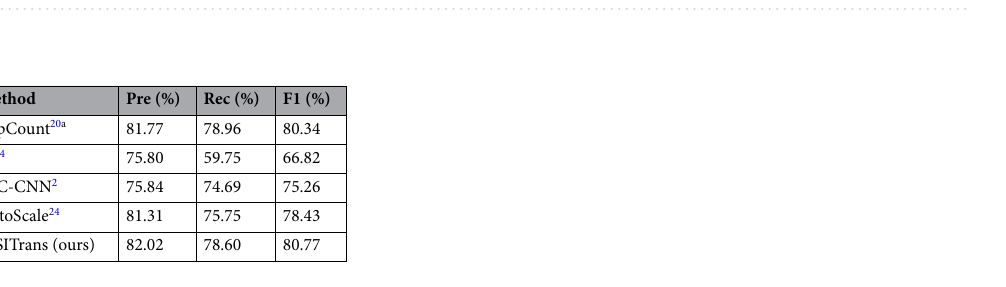
Table 4. Localization performance on the UCF-QNRF dataset. a Means the methods rely on box-level instead of point-level annotations.